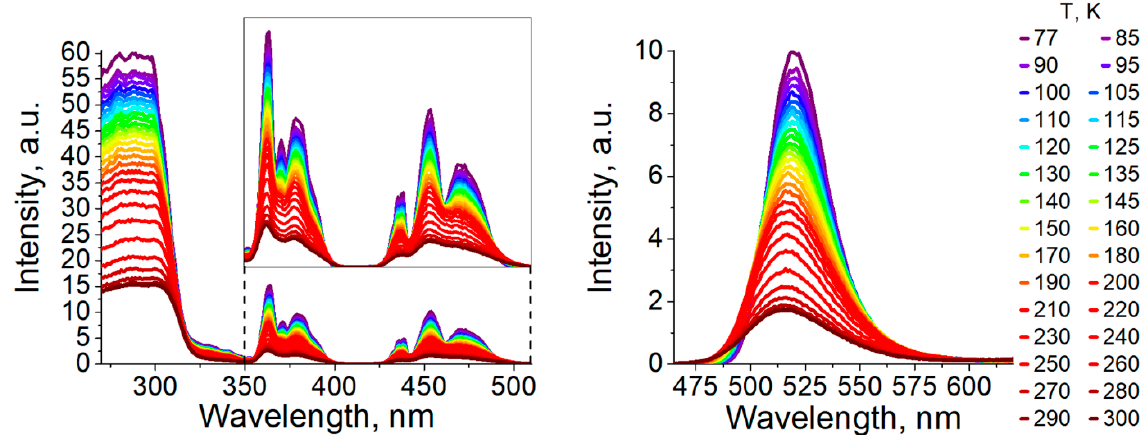
Figure 1. Temperature dependences of the photoluminescence excitation spectra ( λ Em = 520 nm) and photoluminescence spectra ( λ Ex = 453 nm) of 1 .